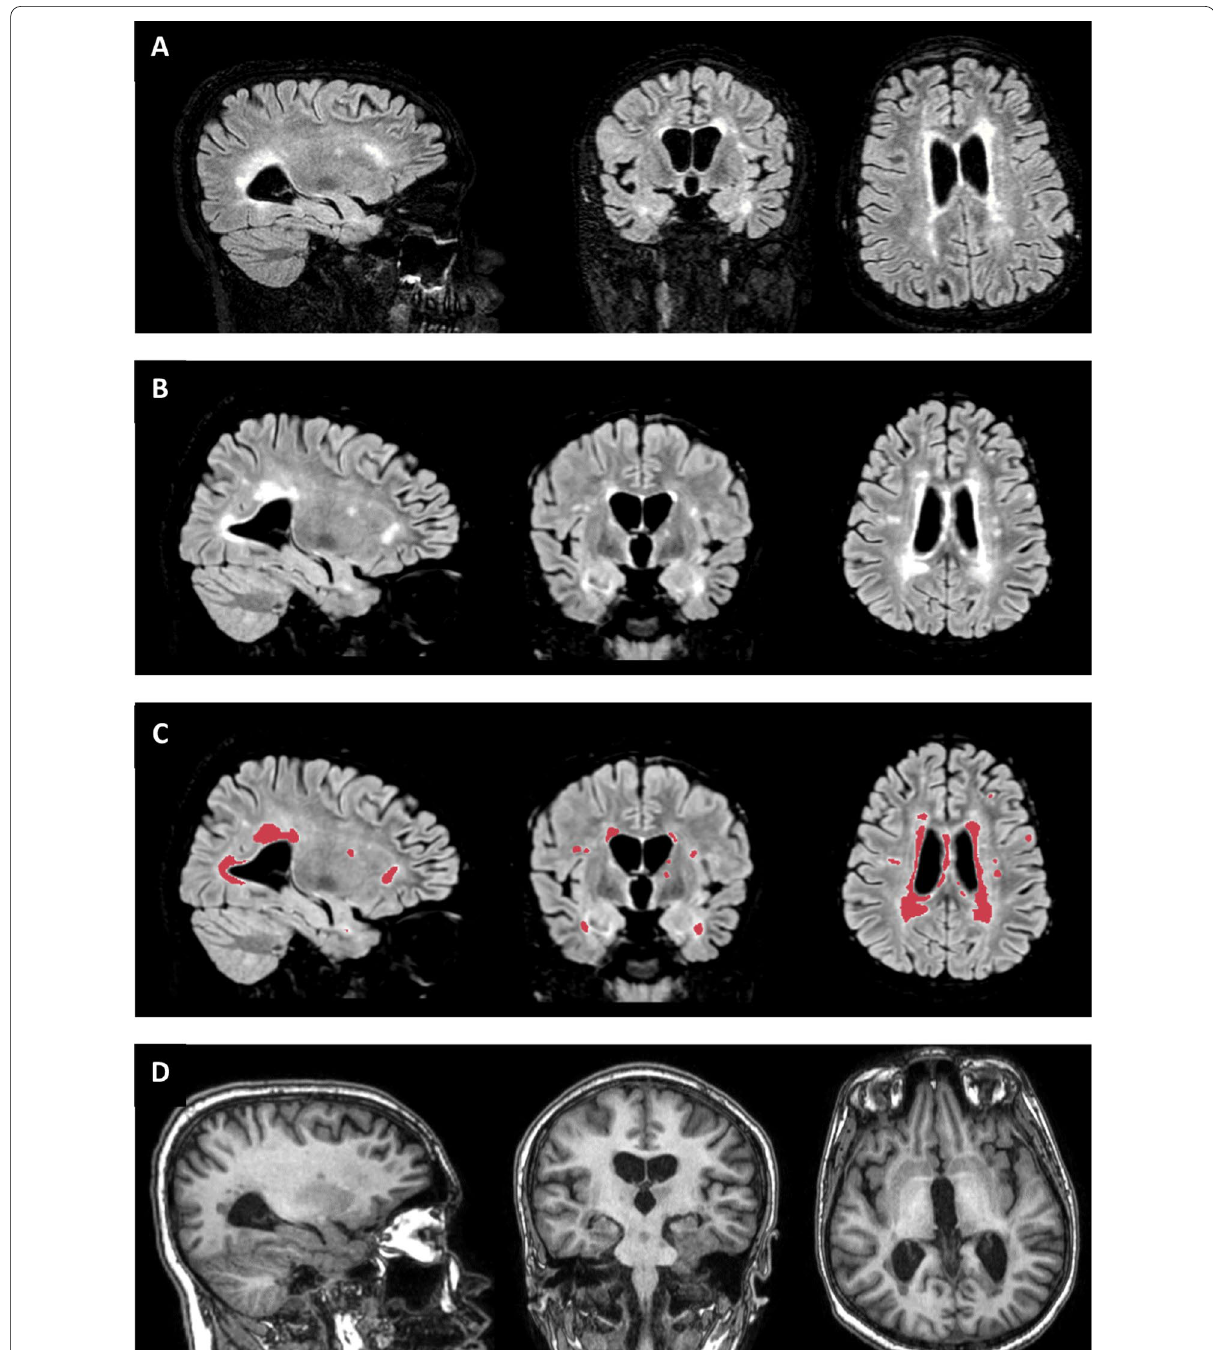
Fig. 8 A female patient aged 24 years, known to have RRMS with EDSS score of 3. White matter lesions segmentation: T2 FLAIR images in sagittal, coronal, and axial planes; a raw unprocessed image showing white matter hyperintense lesions located mainly at the periventricular white matter with a few small juxtacortical lesions, b T2 FLAIR image after registration to MNI template and c processed T2 FLAIR image with segmented white matter lesions. Deep grey matter structures segmentation: T1W images in sagittal, coronal, and axial planes; d raw unprocessed T1W images, e T1W images after registration to MNI template, and f and g T1W images with coloured segmented grey matter structures with thalamus in orange, caudate in red, putamen in green, and hippocampus in blue. Grey matter structures volumes after correction for ICV: Left and right thalamus: 0.00404 and 0.00329 cm 3 , left and right caudate: 0.00277 and 0.00272 cm 3 , left and right putamen: 0.00285 and 0.00270 cm 3 , left and right hippocampus: 0.00272 and 0.00277 cm 3 . White matter lesions volume: 6.75 cm 3 . We found that the patient had a significant decrease in the volumes of the right thalamus, and the right putamen, and she had white matter lesions volume of 6.75 cm 3 and EDSS score of